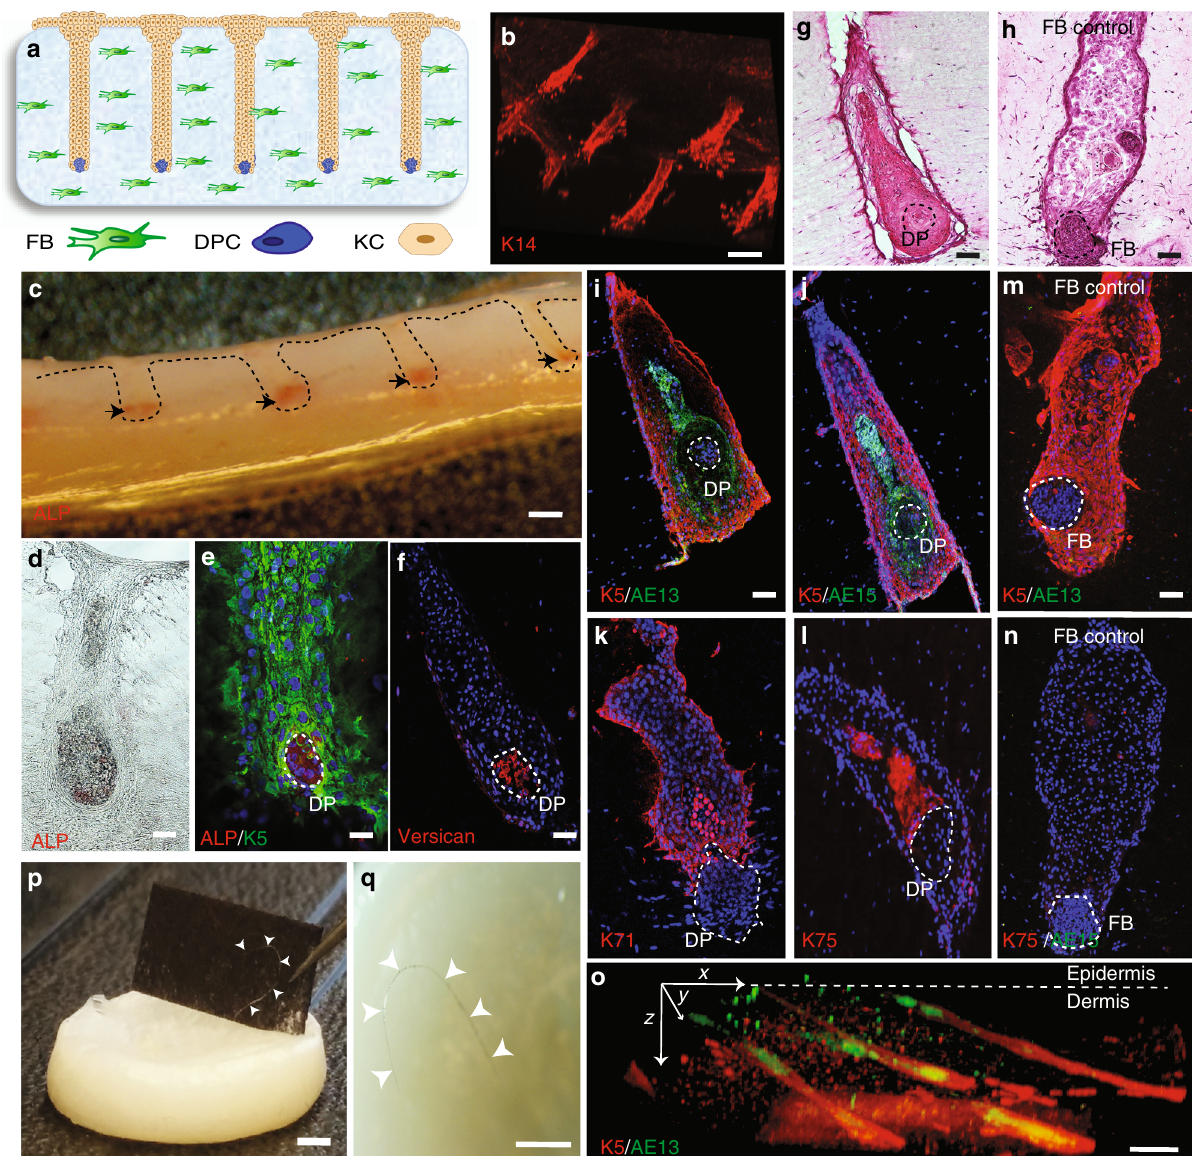
Fig. 2 Differentiation of human keratinocytes into speci fi c hair follicle lineages in HSCs. a Schematic and b 3D-reconstructed image of K14-positive cells showing microwells fi lled with KCs after a day of culture. c Cross section of the whole HSCs with the ALP-active labeled cells at the tip of the microwells (black arrows). Bright- fi eld ( d ) and e , f immuno fl uorescent images of HSCs reveal the physiological conformation of cells where ALP-active and VCAN expressing DPCs (dashed circles) are engulfed by K5-positive KCs after a day of culture, forming HFUs. H&E staining of HSCs depicted the morphological changes of KCs above DPC aggregates ( g ), which was not observed in HSCs with FB aggregates ( h ). KCs in the HSCs expressed speci fi c hair lineage and differentiation markers K5 and AE13 ( i ), AE15 ( j ), K71 ( k ), and K75 ( l ), which was not observed in HSCs with FB aggregates ( m , n ) after a week of culture. o Culture of HSCs for 3 weeks resulted in elongated hair follicles and improved organization of inner and outer root sheaths as shown by the K5 and AE13 markers, respectively. p , q Prolonged culture period led to hair fi ber formation and protrusion from the HSCs (arrow heads indicate the hair fi ber). Scale bars for ( b ), ( c ) and ( o − q ) are 2 mm and for ( d − n ) are 100 µ m ( n = 9; three technical and three biological